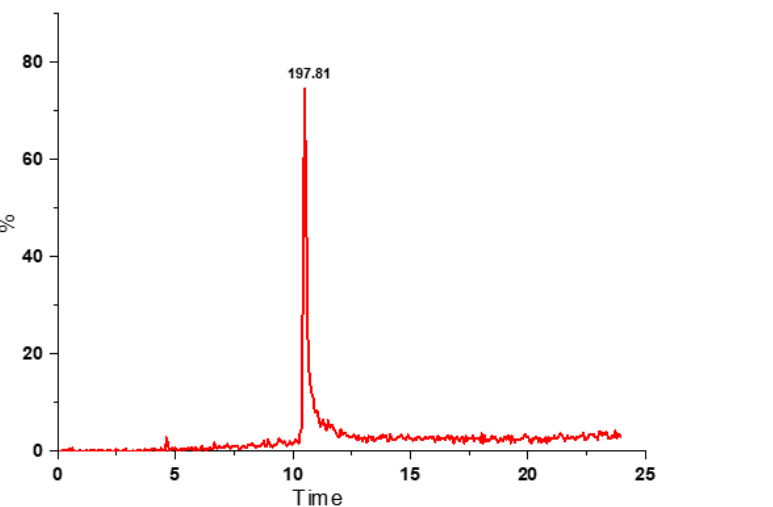
Figure 4. Ultra-performance liquid chromatography-mass spectrometry chromatogram of the extract of O. bataua seed.